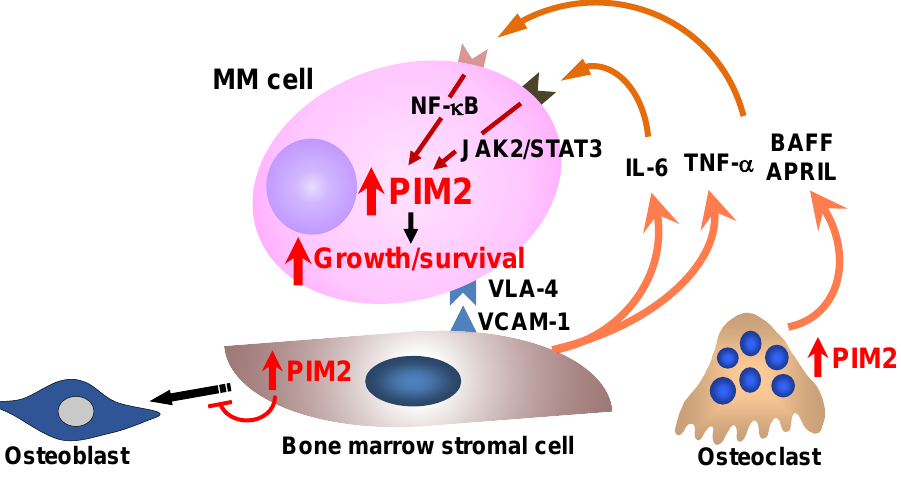
Figure 2. Enhanced expression of PIM2 in MM bone lesions. PIM2 is a novel pro-survival mediator for MM cells. Interaction with MM bone marrow microenvironment potentiates PIM2 expression in MM cells through activation of the JAK2/STAT3 pathway for IL-6 and the NF- κ B pathway for TNF family cytokines, TNF α , BAFF, and APRIL, to promote MM cell growth and survival. At the same time, PIM2 is induced in osteoclasts and bone marrow stromal cells through the interaction with MM cells to cause bone destruction. Therefore, PIM2 is overexpressed in MM cells, and bone marrow microenvironment in MM appears to be an important therapeutic